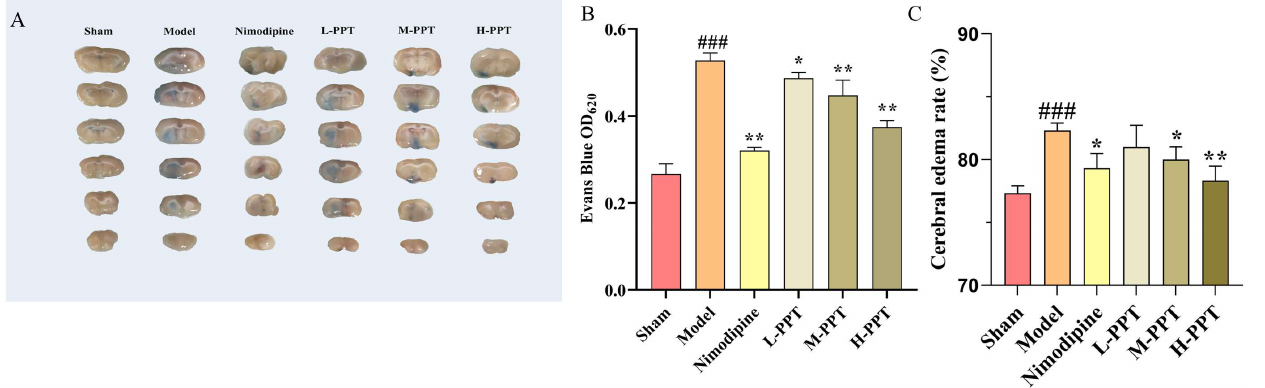
Figure 3. Effect of PPT on blood-brain barrier disruption ( n = 3). The staining and content determi- nation of Evans blue in different groups ( A , B ). The change in cerebral edema rate in different groups ( C ). ### p < 0.001 vs. sham. * p < 0.05, ** p < 0.01 vs. model group.